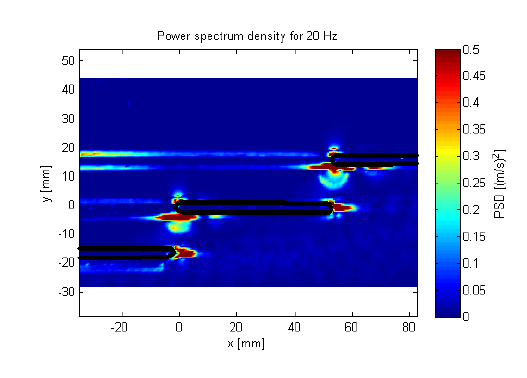
Fig. 7c. PSD scalar map for 20Hz , phase angle ϕ= π .